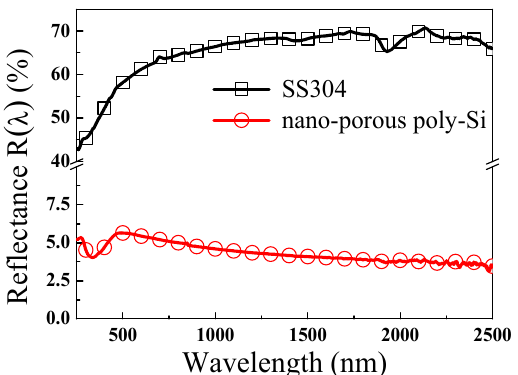
Figure 8. The reflectance ( R ( λ )) from 250 nm to 2500 nm of the reference stainless steel (SS) substrate and the nano-porous poly-Si film on SS substrate. The average reflectance (65%) of the reference SS sample is much higher than the 4.3% of the nano-porous poly-Si film sample.